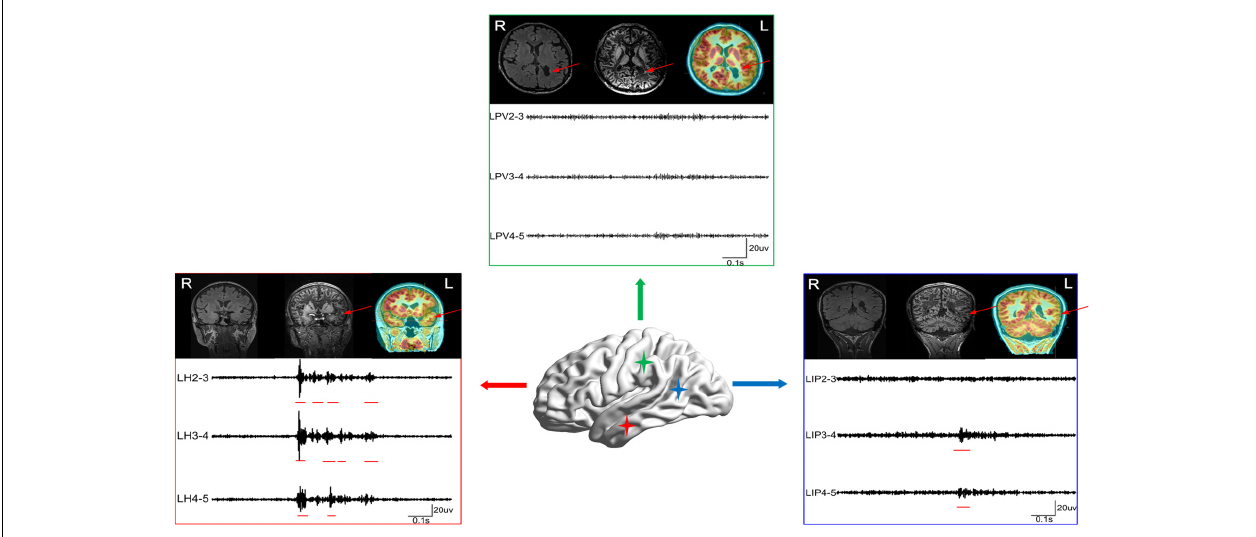
FIGURE 5 | The case of patient #1. Patient #1 was suspected to have gray matter heterotopia in the left medial parietal lobe (near ventricle) based on the MRI result, as the heterotopia was obvious both in PET-MRI and FLAWS. According to the HFO analysis, channels located in this region exhibited greatly fewer FRs than channels in left hippocampus and left posterior temporal region. The three boxes represent three lesions marked using neuroimaging (red arrows) and results of FRs (red lines). LPV, left periventricle; LH, left hippocampus; LIP, left inferior frontal gyrus. The red arrows indicate the marked abnormal